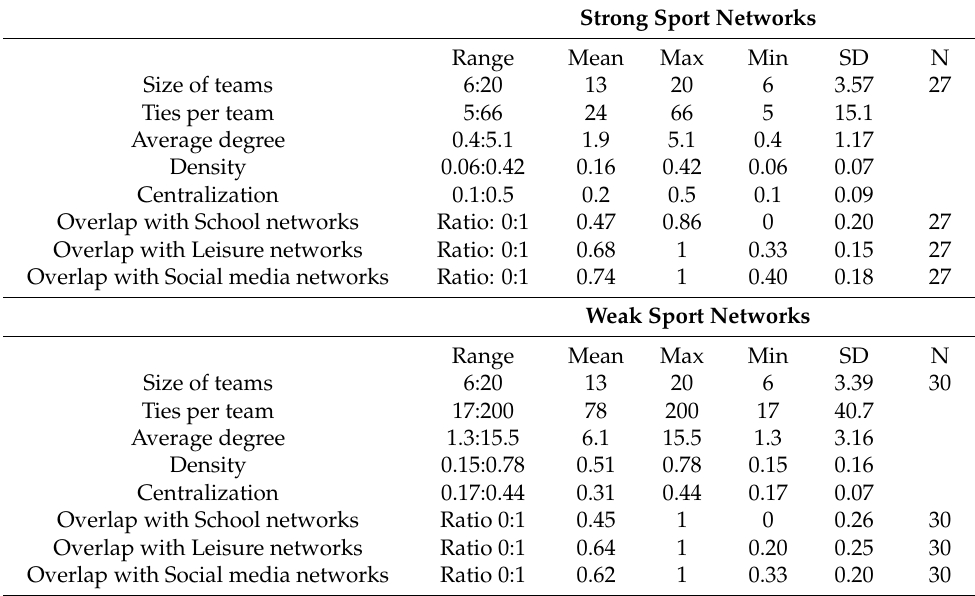
Table 1. Descriptive statistics of (i) network ties and (ii) proportion of overlap between